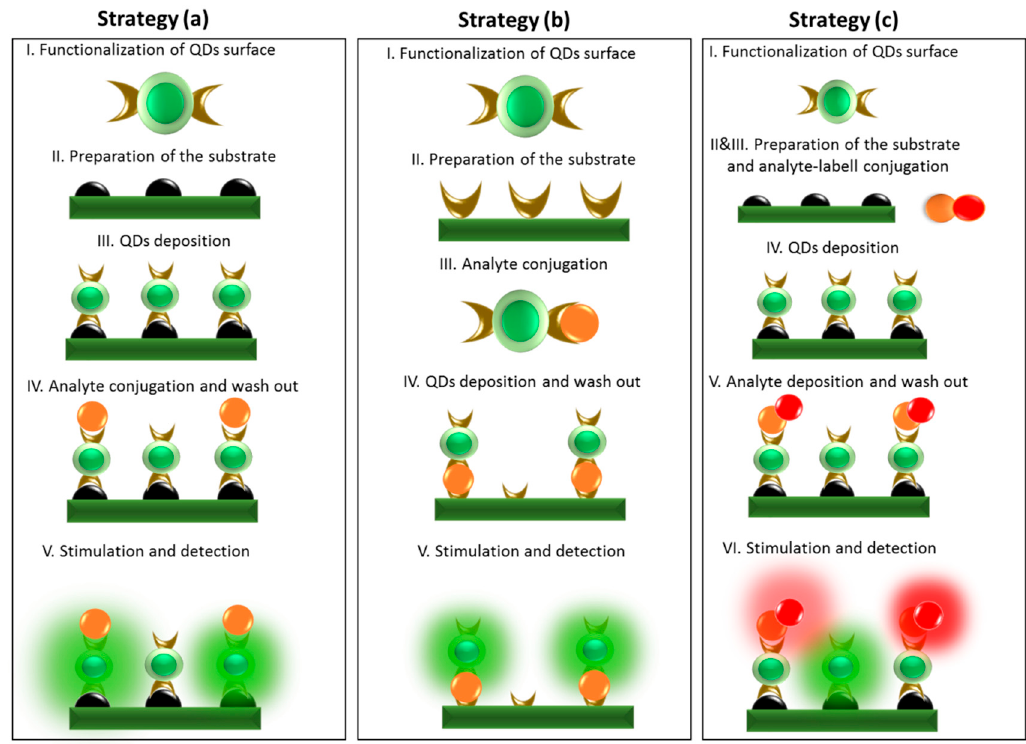
Figure 4. Three examples of the strategy of QDs-based optical sensors (strategy a —modification of substrate with QDs directed to detection of analyte, strategy b —modification of substrate for detection of analyte-QDs complex, strategy c —using the analyte labeled with appropriate fluorophore).